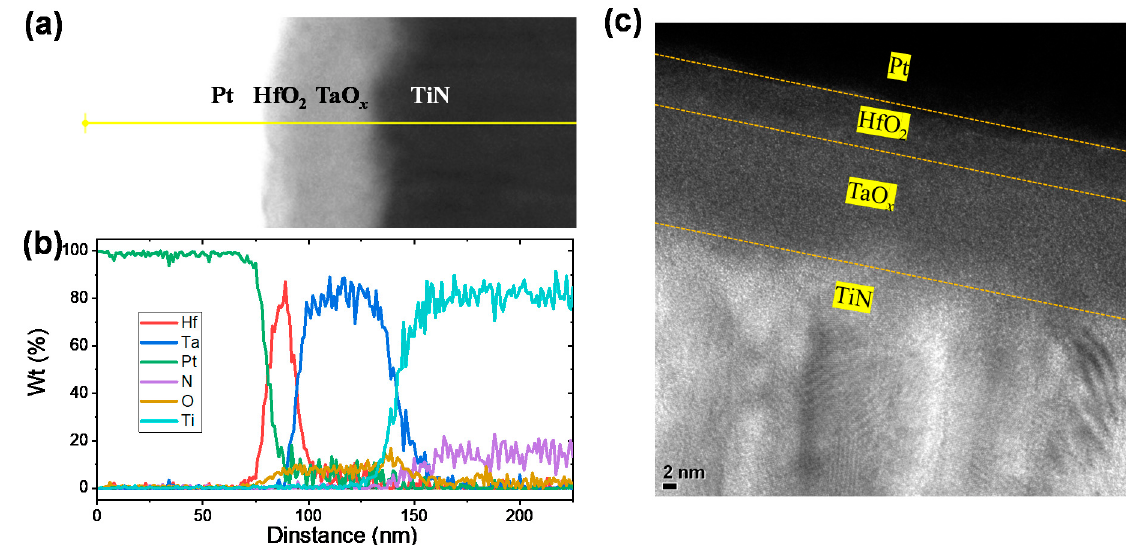
Figure 1. ( a ) STEM image, ( b ) EDS line scan, and ( c ) TEM image of Pt/HfO 2 /TaO x /TiN RRAM device.